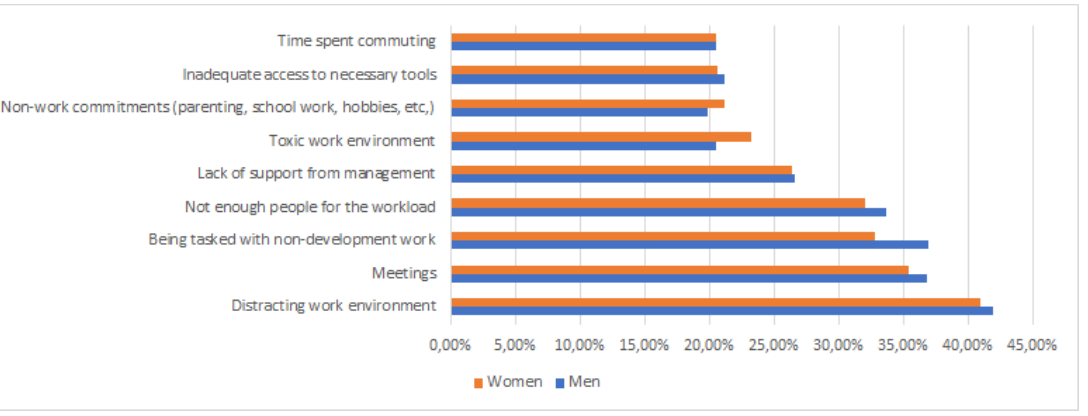
Figure 8. Greatest challenges to productivity (adapted from [49]).